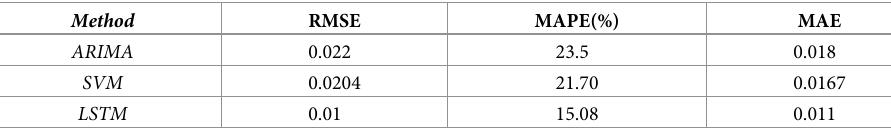
Table 5. Results of different models for monthly incidence